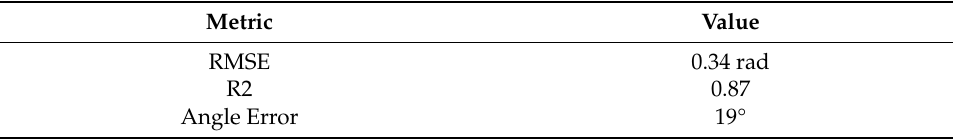
Table 2. Table of the ML model